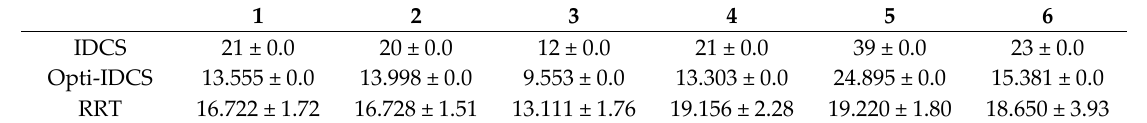
Table 4. Path length in 3D